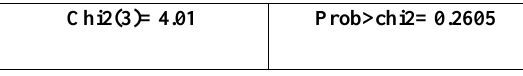
Table 7: Hausman